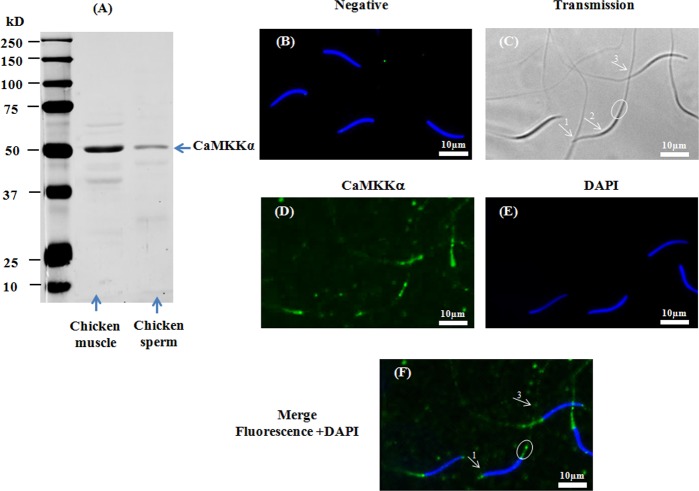
Presence and localization of CaMKKα in chicken sperm.Chicken sperm lysates (45μg of protein) were analyzed by western blotting using anti- CaMKKα as primary antibody. Cell lysates from chicken muscle (40μg of protein) were used as positive control. A band of approximately 50kDa for CaMKKα was detected (1A). Indirect immunofluorescence of chicken sperm was carried out with the same antibody. Negative control: primary antibody was not added (1B). White arrows and circles in transmission images indicate areas of the acrosome (arrow 1), the nuclei (arrow 2), the midpiece (circle), and the principal piece of the flagellum (arrow 3) in sperm (1C). Immunofluorescence staining of CaMKKα (1D, green) was conducted; nuclei were stained with DAPI (1E, blue). Merged images of fluorescence with DAPI staining are shown in Fig 1F (white arrows and circles indicate regions containing CaMKKα immunoreactivity: arrow 1: acrosome; arrow 3: principle piece; circle: midpiece). Scale bar: 10μm.